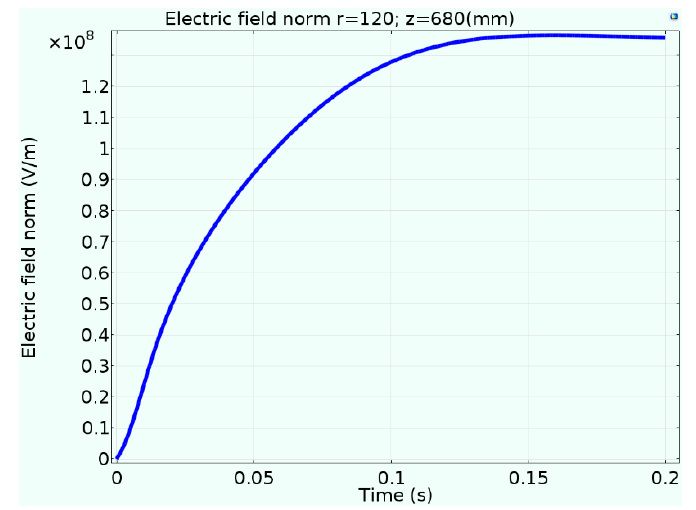
Figure 9. Spatial electric field distribution at the initial moment.